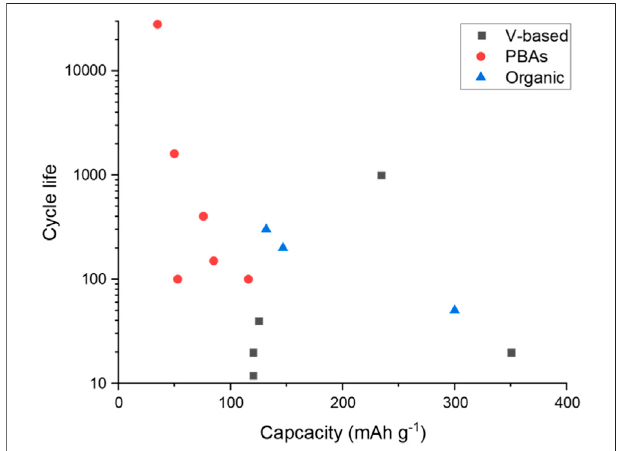
FIGURE 5 | Cycle life plotted against speci fi c capacity reported for TiO2 and MoO3 half-cells (Liu et al., 2012; Kazazi et al., 2017).